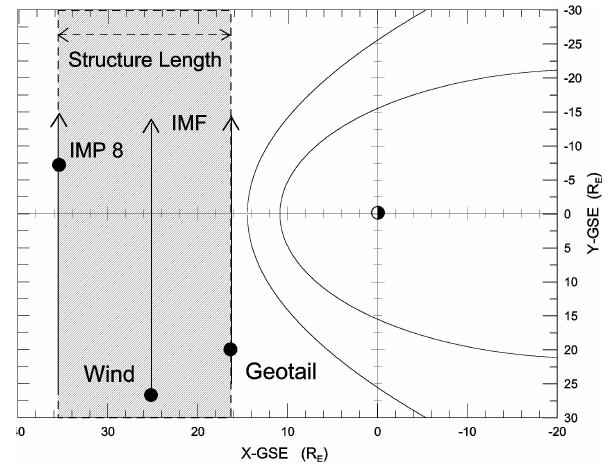
Fig. 6. A solar wind pressure pulse (shaded area) on 2 July 1997, convecting anti-sunward. IMP-8, Wind and Geotail record the up- stream of the bow shock conditions. The satellite positions are pro- jected on the XY GSE plane.